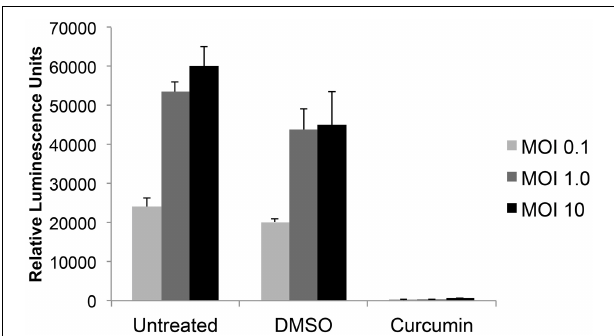
FIGURE 1 | RVFV luciferase assay development. Vero cells were either untreated or preincubated with DMSO or 10 µ M curcumin for 1h prior to infection with MP12 1 NSs-Luc (MOI 0.1, 1.0, or 10). After 1h infection, virus inoculum was removed, cells washed and media containing respective treatments was added back to cells. Twenty-four hours post infection (hpi), luciferase activity was measured and graphed in relative luminescence units (RLU). The average and standard deviation of three biological replicates are